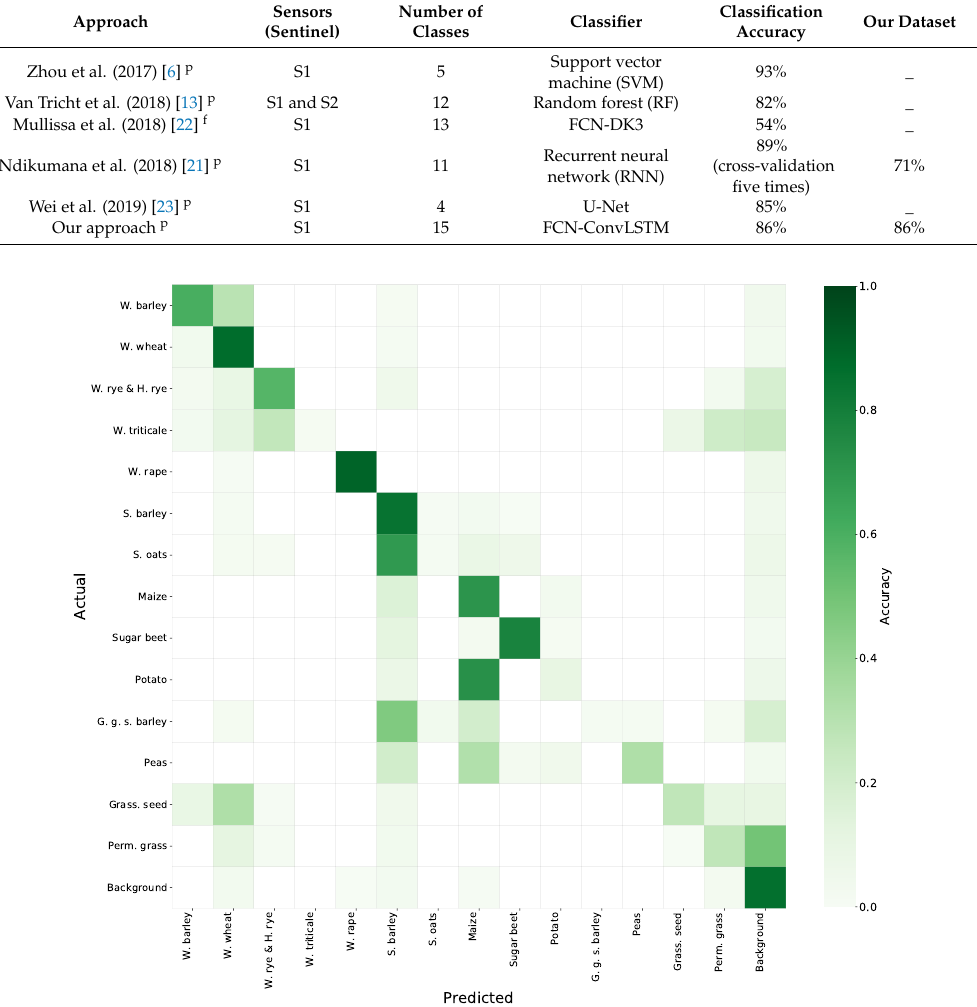
Figure 14. Normalized confusion matrix by [21] on our